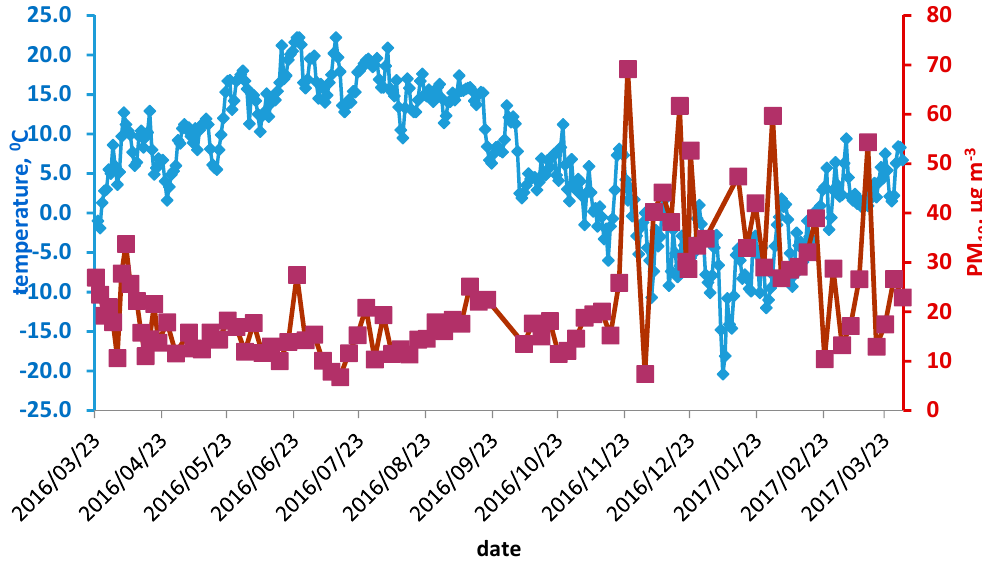
Figure 2. Seasonal variation of PM 10 concentrations and temperature at the site.